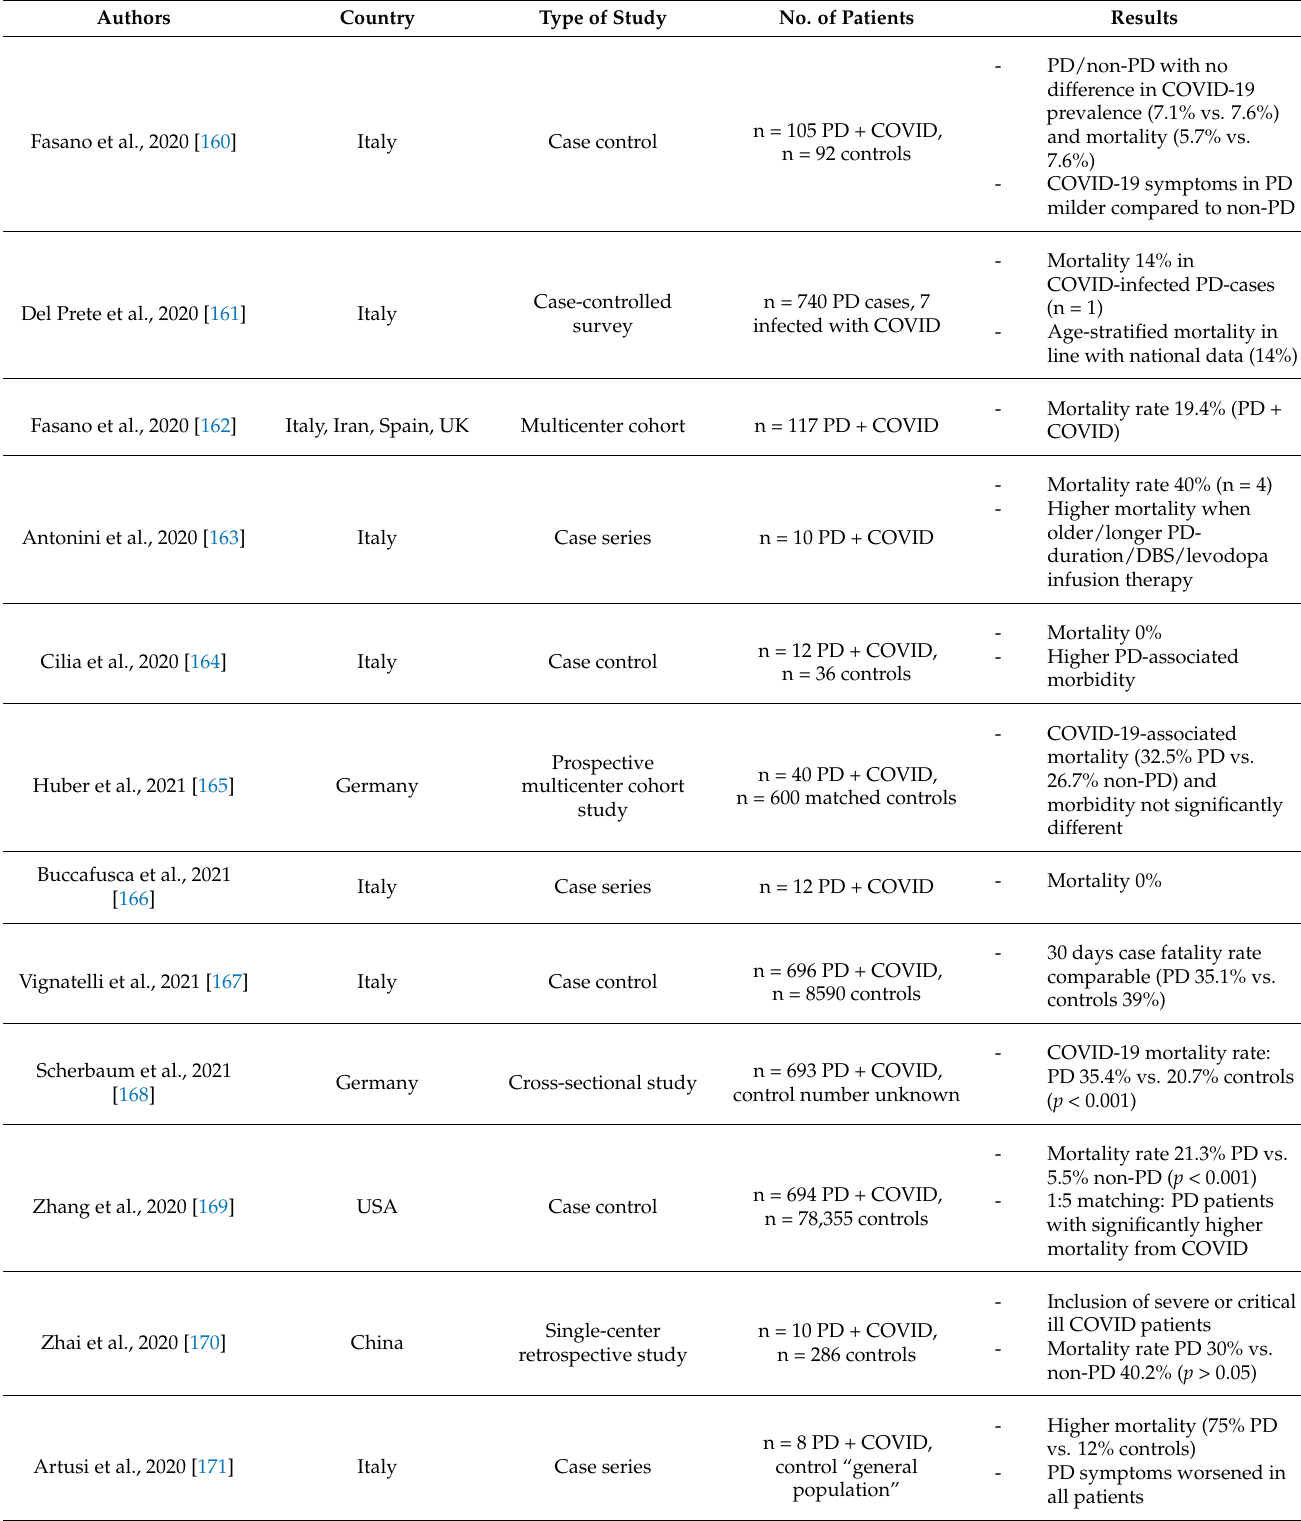
Table 1. Mortality and morbidity in COVID-19 PD cases versus COVID-19 non-PD